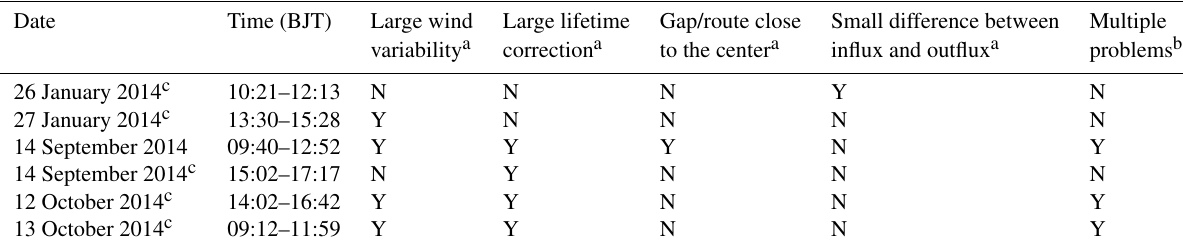
Table 2. Overview of the problems for the six circling journeys.